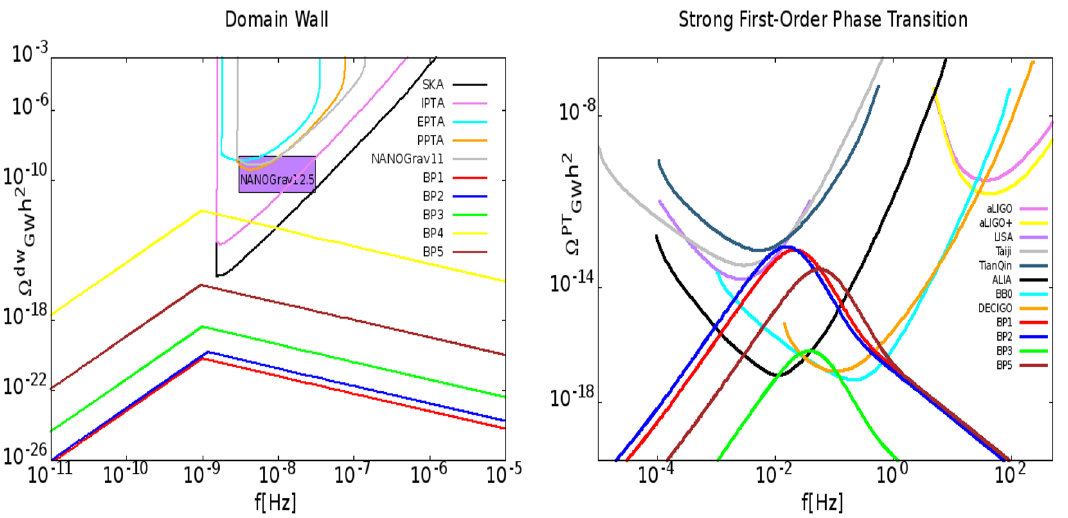
Figure 3. The GW intensity versus the frequency. Left panel: comparison with the sen- sitivity curves of pulsar timing arrays such as SKA, IPTA, EPTA, PPTA, NANOGrav11 and NANOGrav12.5 (purple coloured rectangular box) from the contribution of the annihilation of domain walls. Right panel: comparison with the sensitivity curves of future GW detectors such as ALIA, BBO, DECIGO, LISA, TianQin, Taiji, aLIGO and aLIGO+ from the contribution of strong first-order phase transition using the same